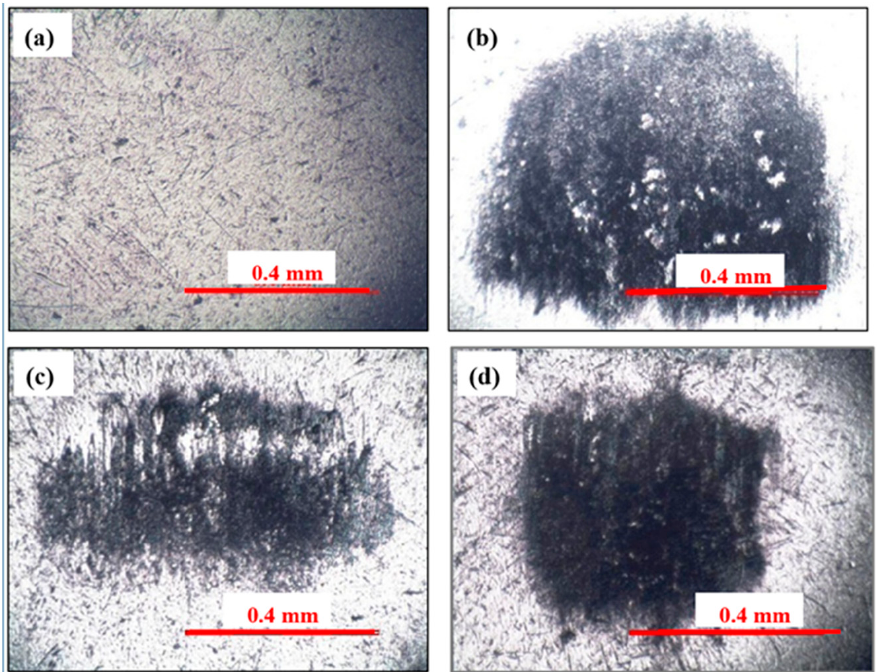
Figure 11. Optical microscope images of steel ball ( a ) unworn surface; and worn surfaces showing